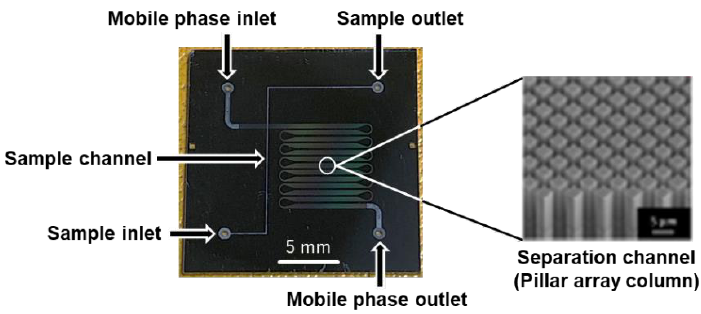
Figure 4. Pillar array columns used in this study .